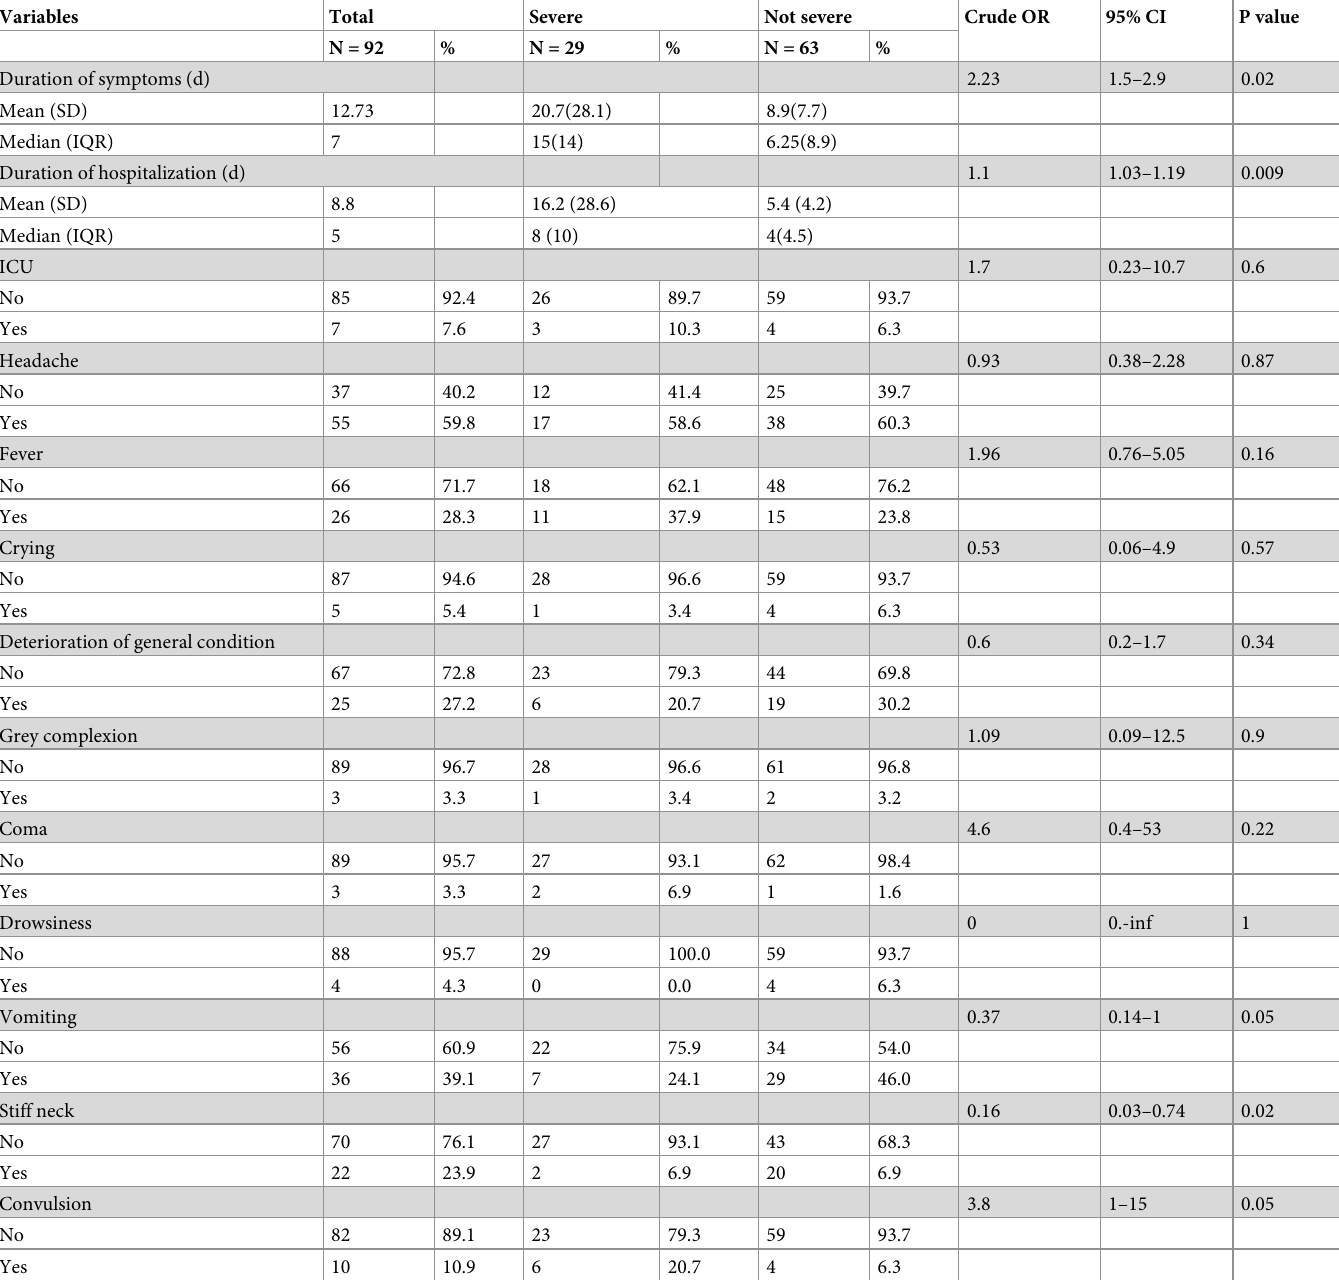
Table 2. Clinical features of New Caledonian cases of EM from 2004 to 2019 according to severity, n = 92.